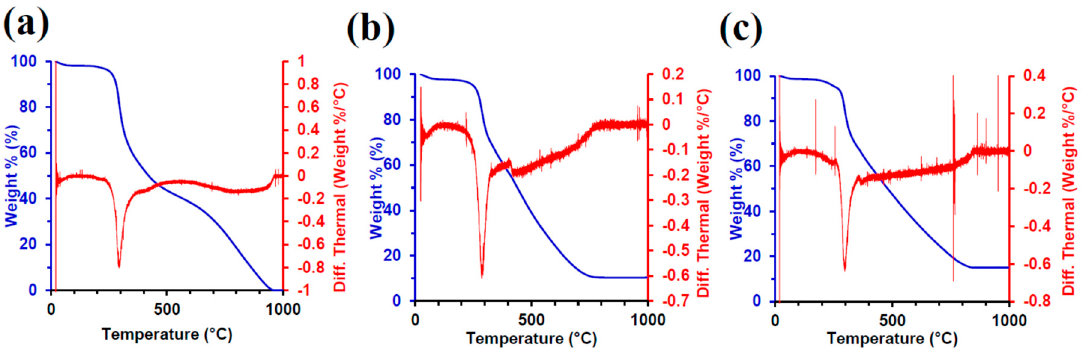
Figure 4. Thermogravimetric analysis (TGA) with differential thermal analysis (DTA) for the ( a ) silk